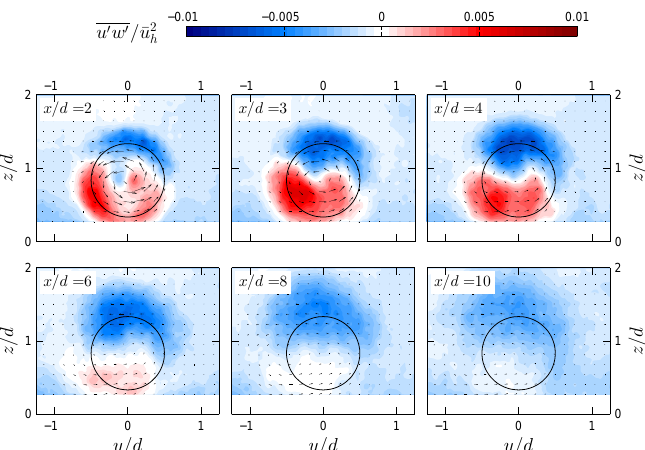
Figure 7. Contours of the normalized vertical momentum turbulent flux u (cid:48) w (cid:48) / ¯ u 2 at different downstream locations for the miniature turbine operating at λ = λ o . The vector field represents the in-plane velocity components. The black circles show the frontal area of the wind turbine.